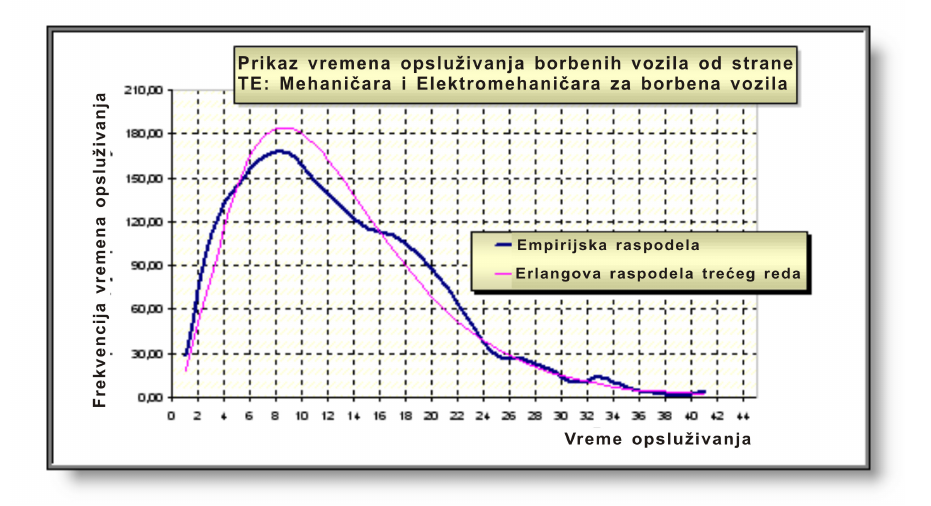
U tre ć em slu č aju tenkove i transportere opslužuju mehani č ari i elek- tromehani č ari za b/v. Prikaz vremena opsluživanja tenkova i transportera dat je na slici 13.